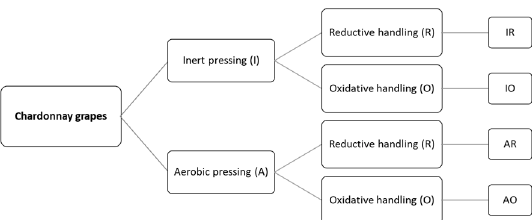
Scheme 2. Experimental design showing the four combinations of oxygen exposure regimes during pressing and handling: inert-reductive (IR), inert-oxidative (IO), aerobic-reductive (AR) and aerobic- oxidative (AO).